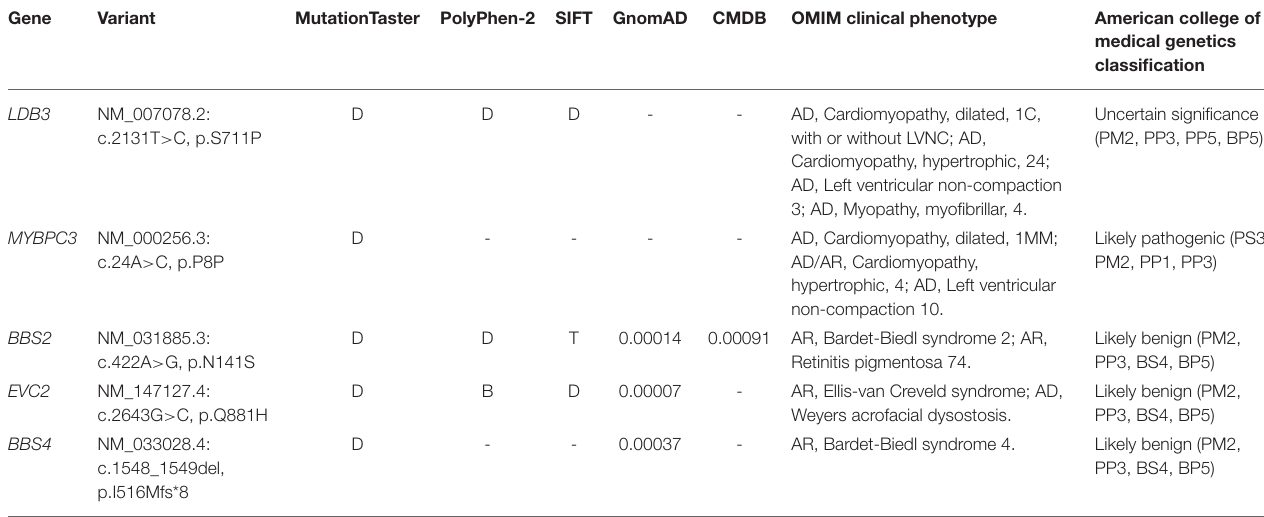
TABLE 1 | Variants identified in the deceased by whole-exome sequencing (WES) in combination with the filtration of cardiopathy-related genes. Gene